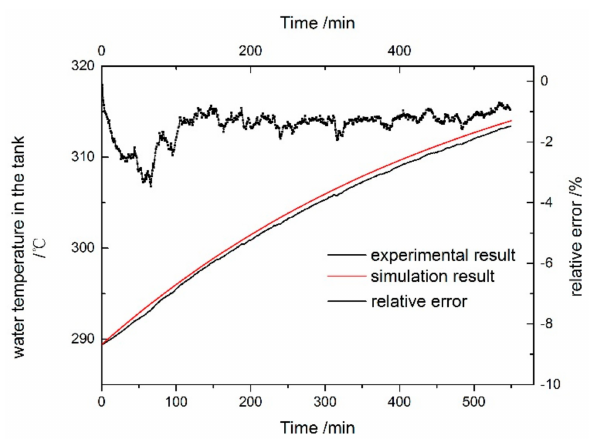
Figure 5. Temperature comparison of water tank.